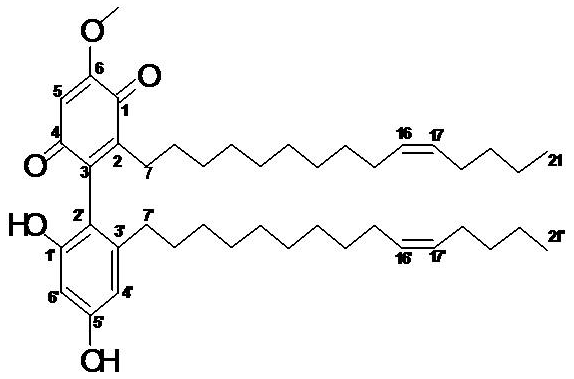
Figure 2. Chemical structure of demethylbelamcandaquinone B.